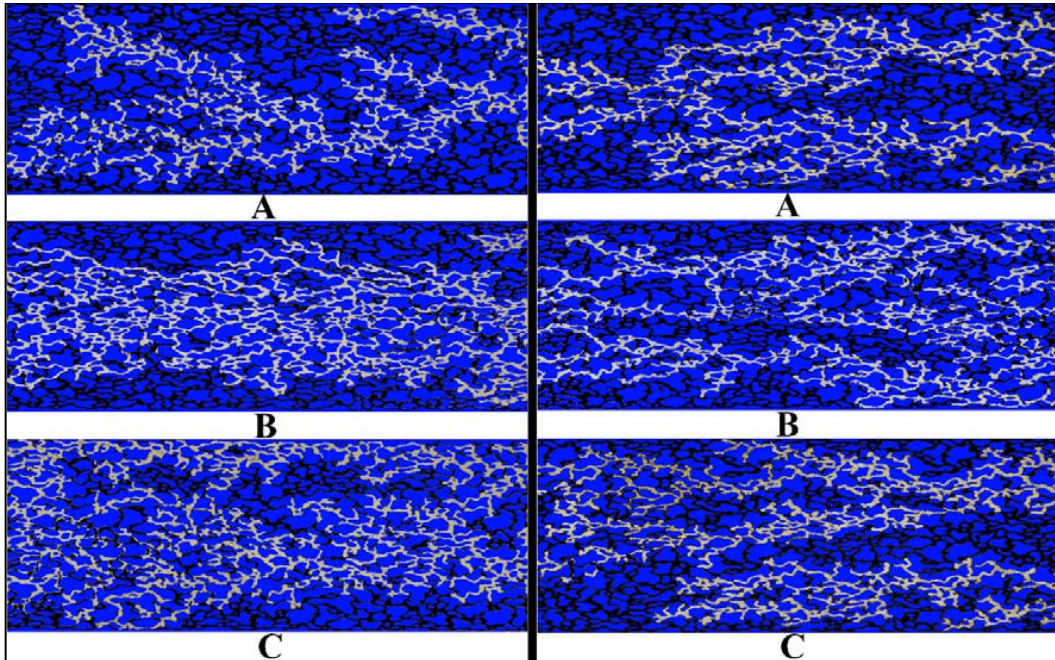
Fig. 6. Macroscopic photos of ultimate recovery for water (left) and Ethanol (Right) base fluid: A) 0 wt.%, B) 3 wt.% and C) 5 wt.% of silica nanoparticles